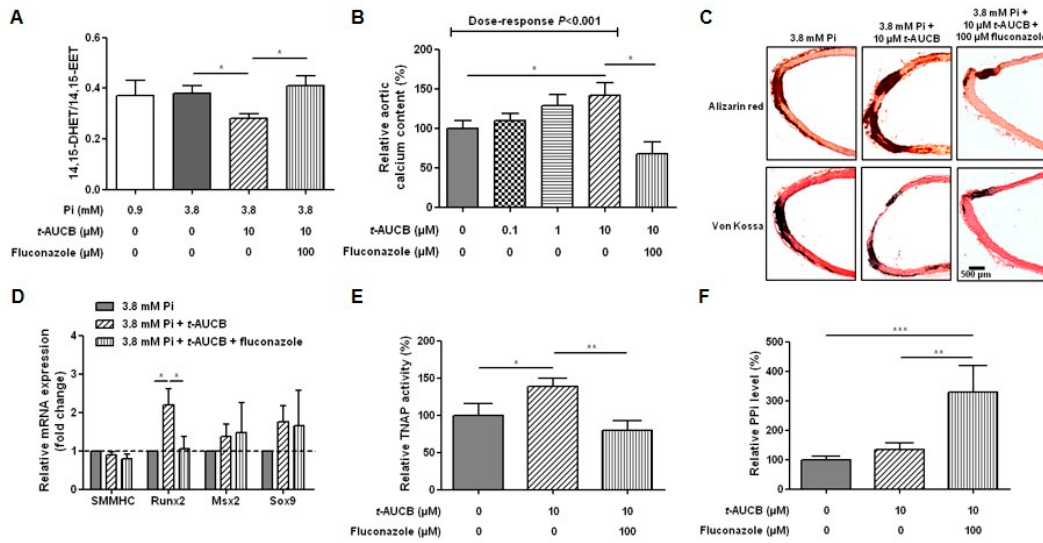
Figure 2. Ratio of 14,15-epoxyeicosatrienoic acid-to-14,15-dihydroxyeicosatrienoic acid (14,15-EET-to- 14,15-DHET) in the supernatants of aortic rings cultured for 7 days in normal (0.9 mM inorganic phosphate, Pi) and high-phosphate (3.8 mM Pi) conditions in the absence and in the presence of 10 µ M trans -4-(4-(3-adamantan-1-yl-ureido)-cyclohexyloxy)-benzoic acid ( t -AUCB) and in 10 µ M t -AUCB + 100 µ M fluconazole (( A ) n = 4–9 per group). The relative calcium content of aortic rings cultured for 7 days in 3.8 mM Pi in the absence and in the presence of increasing concentrations of t -AUCB alone and associated with fluconazole (( B ) n = 6–16 per group) and representative images of Alizarin red and Von Kossa staining ( C ). Aortic mRNA expression levels of the contractile marker smooth muscle myosin heavy chain (SMMHC) and of the osteochondrogenic markers Msh homeobox 2 (Msx2), sex-determining region Y-box 9 (Sox9) and runt-related transcription factor 2 (Runx2) (( D ) n = 4–22 per group) tissue-nonspecific alkaline phosphatase (TNAP) activity (( E ) n = 13–18 per group) assessed by measuring the hydrolysis of p-nitrophenyl phosphate (pNPP) and pyrophosphate anions (PPi) level (( F ) n = 4–13 per group) in culture supernatants after 7 days of culture in high-phosphate (3.8 mM Pi) conditions in the absence and in the presence of 10 µ M t -AUCB and 10 µ M t -AUCB + 100 µ M fluconazole. * p < 0.05, ** p < 0.01 and *** p < 0.001.